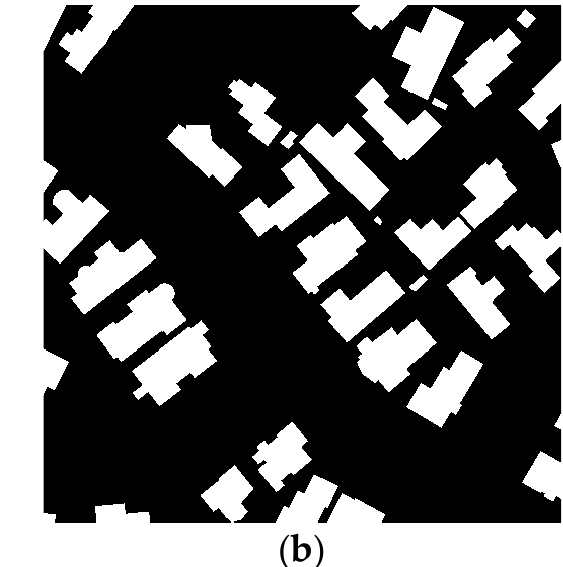
( b ) Figure 9. Image and label example selected from the China typical cities building dataset: ( a ) Orig- inal image; ( b ) Ground truth. Black and white pixels mark non-building and building, respectively. 3.2. Data Processing The data enhancement method increases the training sample by sample expansion to avoid overfitting of the model [45]. In this study, the samples were subjected to vertical and horizontal mirror flips as well as rotations of different angles. Figure 10 shows an example of the imagery after data processing and enhancement. Image Label Original Rotate 90° Flip horizontally Figure 10. An example of data augmentation by rotating and flipping.